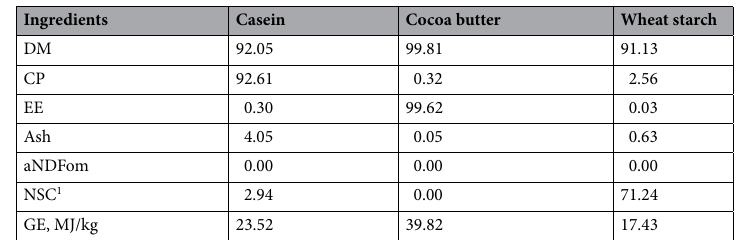
Table 5. Chemical composition (g/100 g as is) and gross energy of the semi-purified ingredients used for the 5 experimental diets. DM: dry matter, CP crude protein, EE ether extract, aNDFom amylase neutral detergent fiber organic matter, NSC non-structural carbohydrates, GE gross energy. a Values are reported as mean of duplicate analyses. 1 Calculated as 100−[(100−DM) + CP + EE + Ash + aNDFom].